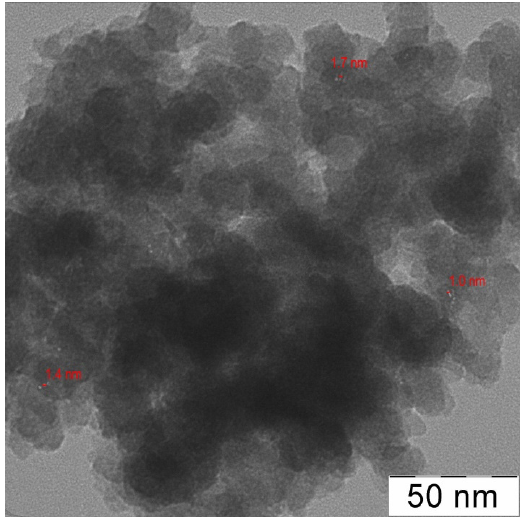
Figure 2. TEM microphotography of hybrid G3-dendr-SiO 2 material.